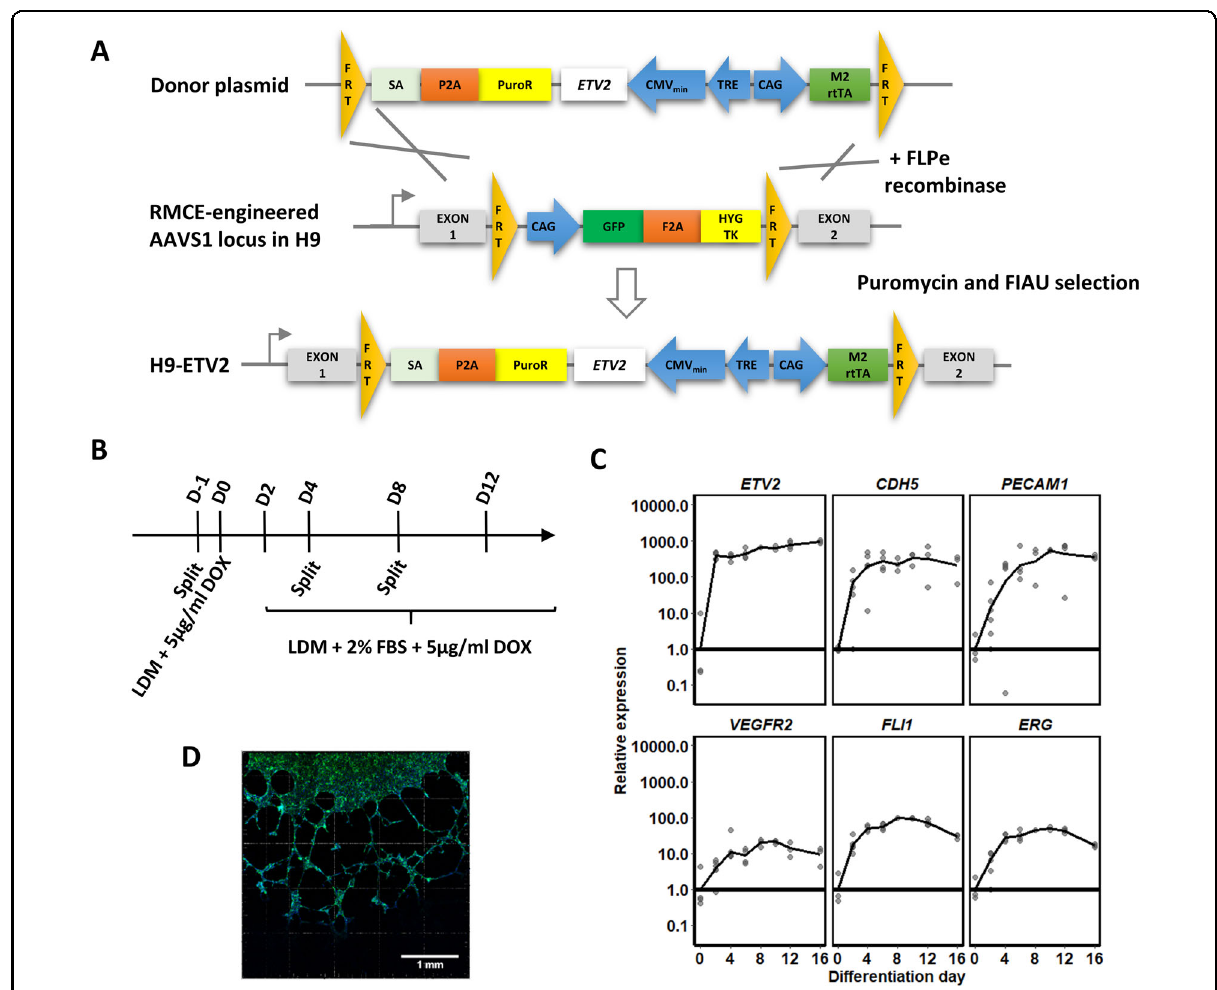
Fig. 1 Generation and characterisation of ETV2-ECs. A H9 human embryonic stem cells engineered with an RMCE cassette were recombined with a doxycycline-inducible ETV2 overexpression cassette (method described in and fi gure adapted from Ordovas et al. 41 ). (FRT Flippase recognition target, SA splice acceptor, PuroR puromycin resistance gene, TRE tetracycline response element, M2rtTA M2 reverse tetracycline transactivator.) B Schematic representation for PSC differentiation into endothelial cells. C Gene expression (RT-qPCR) pro fi le of ETV2 , the endothelial markers CDH5 , PECAM1 , and VEGFR2 , and the endothelial TFs FLI1 and ERG . Samples were collected every 2 – 4 days of differentiation until day 16 with N = 3 biological replicates per time point. Expression is relative to that of day 0 of differentiation (i.e., stem cells). D Confocal image of phalloidin-stained ETV2-ECs in Matrigel showing tube